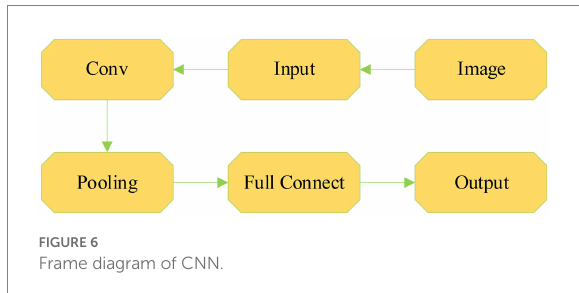
FIGURE 6 Frame diagram of